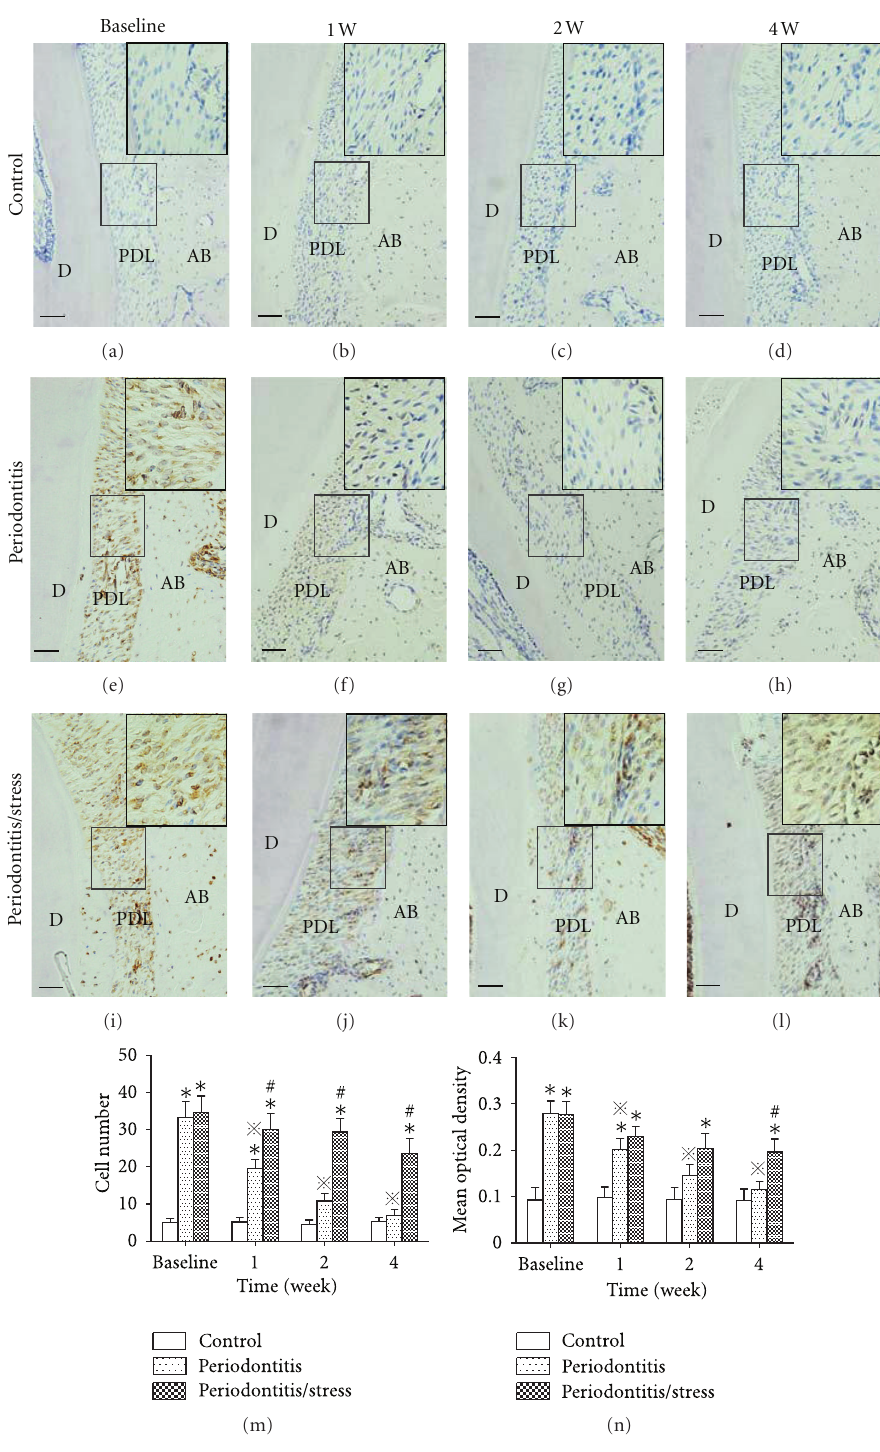
Figure 6: Immunostaining of interleukin-1 β . ((a)–(l)) Area comprising the mesial root surface of the maxillary second molar of all groups 200, bar represents 100 μ m). The boxed areas indicate a at all time points (D: dentin, AB: alveolar bone, and PDL: periodontal ligament, (cid:0) 400). ((m)-(n)) Quantitative analysis of the number of immunoreactive cells (m) and the intensity of staining (n). higher magnification ( (cid:0) P 0 . 05 versus control group at the same time point. # P 0 . 05 versus periodontitis group at the same time point. (cid:2)(cid:0) P (cid:0) (cid:0) (cid:0) same group at